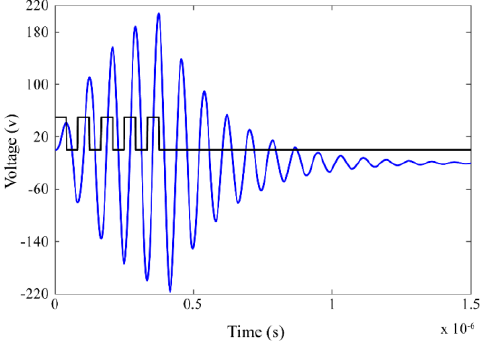
Figure 9. Voltage waveforms of V c2 for n = 5.